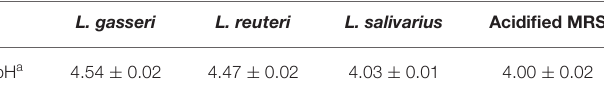
TABLE 3 | pH value of cell-free supernatants from Lactobacillus strains and